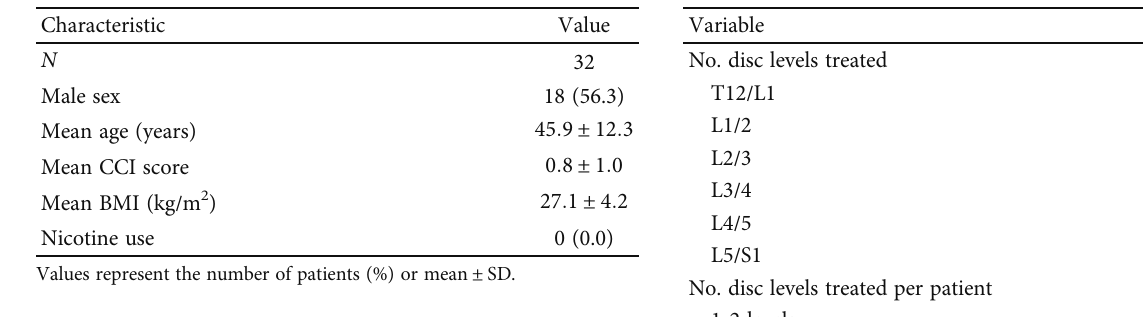
Table 1: Patient characteristics.